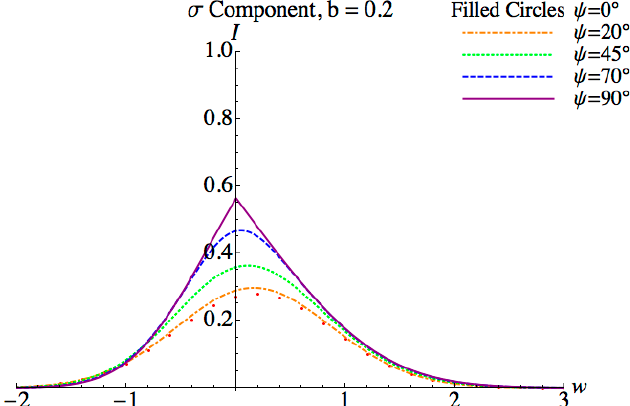
Figure 7. Lorentz–Doppler profiles of σ -components of highly-excited hydrogen/deuterium spectral lines calculated by Equations (6.6) and (6.7), for the scaled magnetic field b = 0.2 (defined in Equation (6.1)) at five different values of the angle of observation ψ with respect to the magnetic field [66].